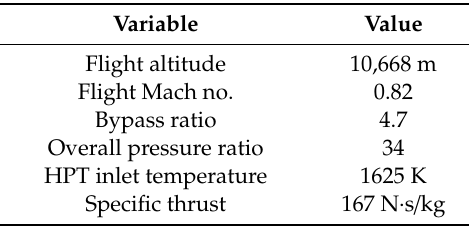
Table 3. Nominal conditions at